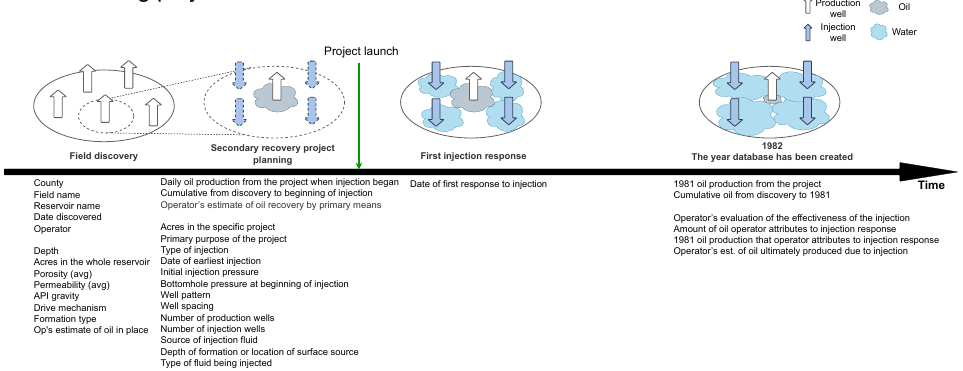
Figure 1. Timeline of the waterflooding project. Scheme depicts which parameters from the database are available for each stage of the project. We strictly separate the parameters known before the start of the project and